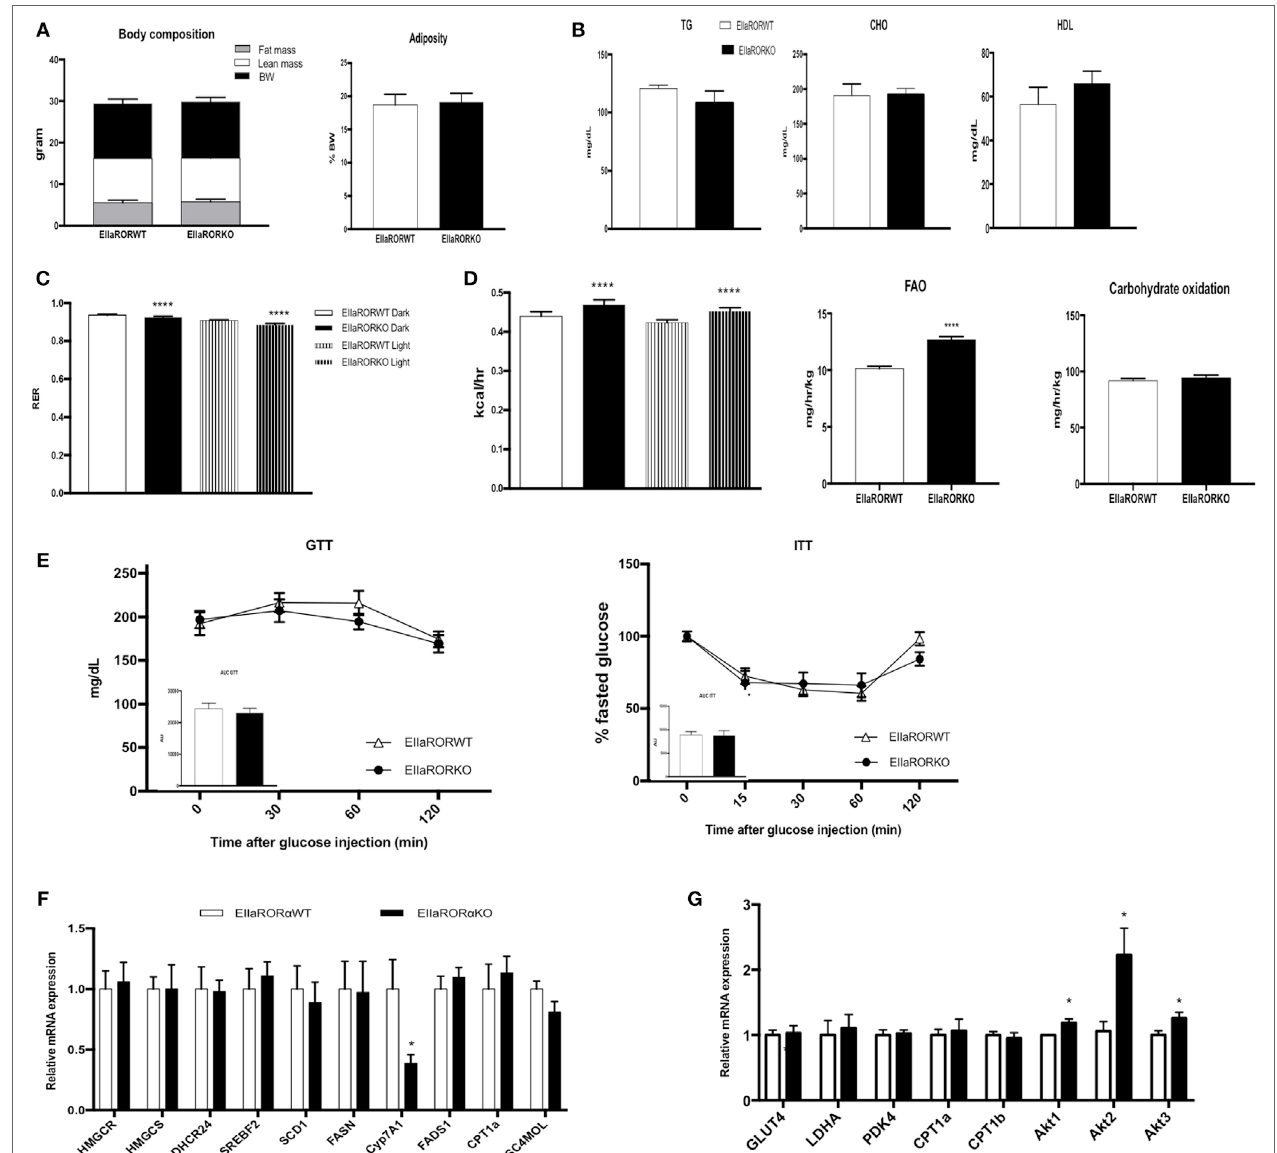
FigUre 2 | EIIAROR α KO mice display an increase fatty acid oxidation and energy expenditure. (a) Body composition of single-housed 12-week-old males EIIAROR α WT ( n = 8) and EIIAROR α KO ( n = 8) littermates (left panel) and adiposity of the same animals (right panel) fed with a normal chow diet. (B) Blood lipid profile (triglycerides, total cholesterol, and HLD) of the same males EIIAROR α WT (white bar, n = 8) and EIIAROR α KO (black bar, n = 8). (c) Respiration exchange ratio and (D) heat production of the same EIIAROR α WT (white, n = 8) and EIIAROR α KO (black, n = 8) littermates during day (solid pattern) or night (shaded pattern) over a 5-day period and after 24 h acclimation (upper panel). Fatty acid oxidation and carbohydrates consumption of the same males EIIAROR α WT (white bar, n = 8) and EIIAROR α KO (black bar, n = 8) calculated over a 5-day period. (e) Glucose (left) and insulin (right) tolerance test from the same males EIIAROR α WT (white triangle, n = 8) and EIIAROR α KO (black square, n = 8). Area under the curve is represented on each graph. (F) Liver and (g) muscle gene expression from the same males EIIAROR α WT (white bar, n = 8) and EIIAROR α KO (black bar, n = 8) (* p < 0.05, **** p <